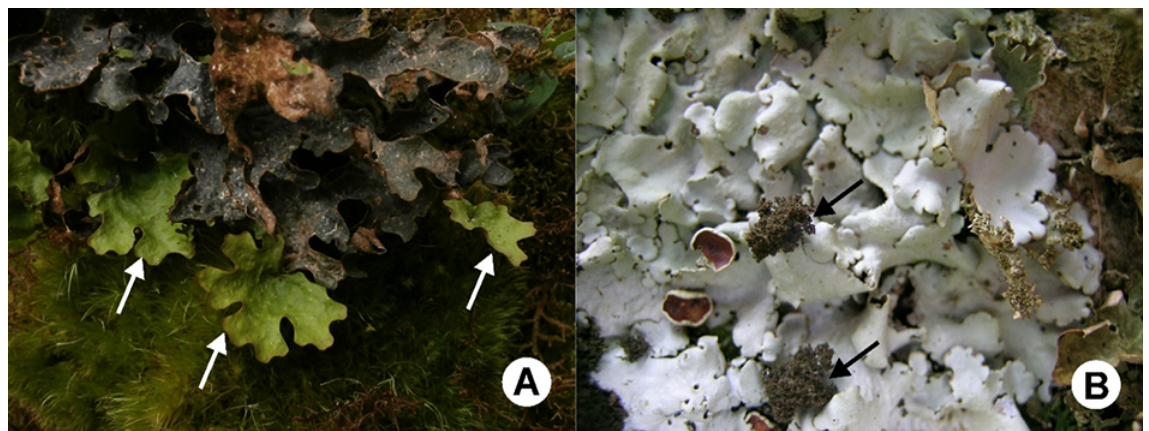
Figure 1 ( A ) Two photomorphs of Stica on the same thallus with chloromorph (arrow) growing out of cyanomorph. ( B ) Dendriscocaulon -like cephalodia (arrow) on thallus of Ricasolia amplissima in